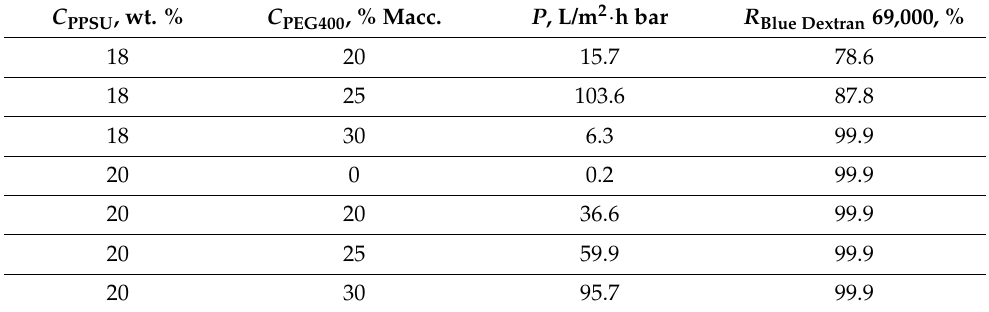
Table 6. The results of measurements of the permeance and rejection of the model dye Blue Dextran. C PPSU , wt. % C PEG400 , %